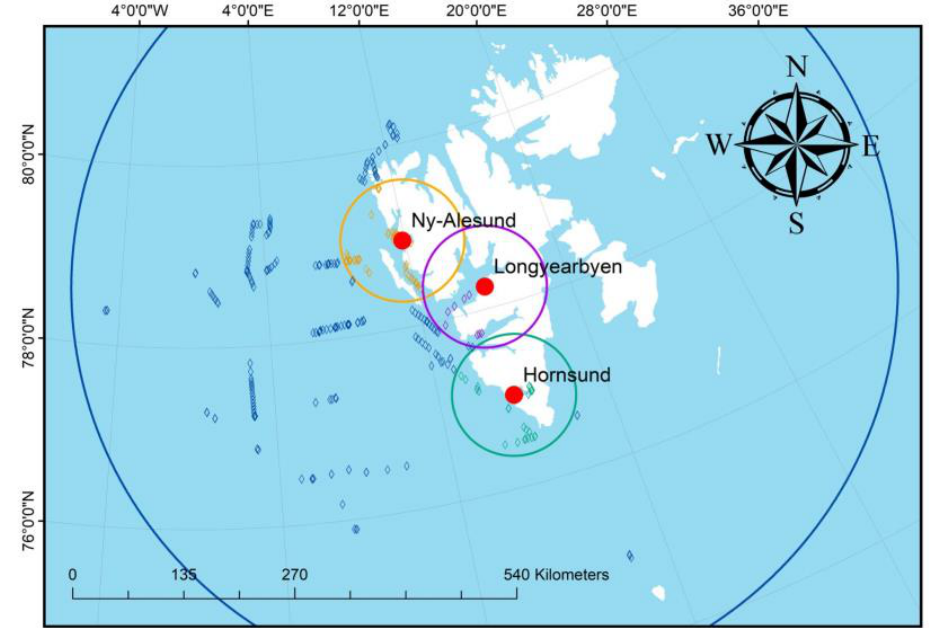
Figure 1. Map of Sites. Ny-Ålesund (Nya), Longyearbyen (Ly), Hornsund (Hor), and Open (O). The boundaries for these locations are marked by different colors. The three specific sites, Nya, Ly, and Hor, are marked by yellow, purple, and green boundaries, respectively. Data points outside of the three sites but within the Svalbard area are considered O, marked by navy. Used with permission from Paulina Pakszys, Horizontal variability of aerosol optical properties over the European Arctic . Ph.D. thesis; published by the Institute of Oceanology Polish Academy of Sciences, 2018.